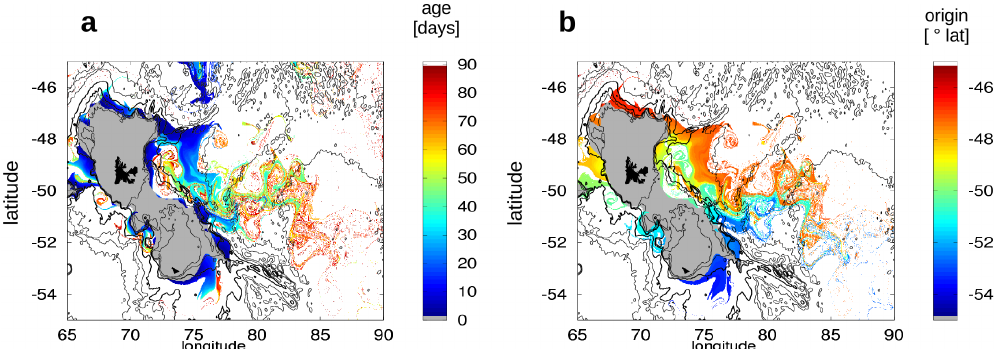
Figure 6. Altimetry-derived estimation of the iron pathways from the plateau to the open ocean: (a) age (days since having left the plateau); (b) latitudinal origin from the